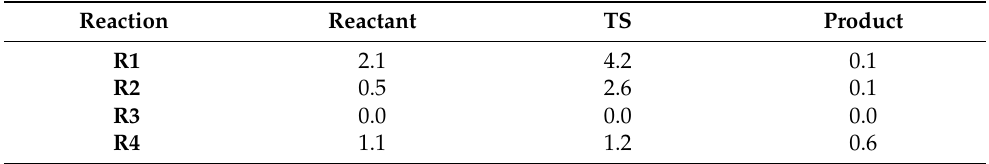
Table 3. The relative energies (kcal/mol) of reactants, TSs and products for R1 – R4 taking reaction R3 as a reference. DLPNO-CCSD(T)/def2-TZVP levels of theory.